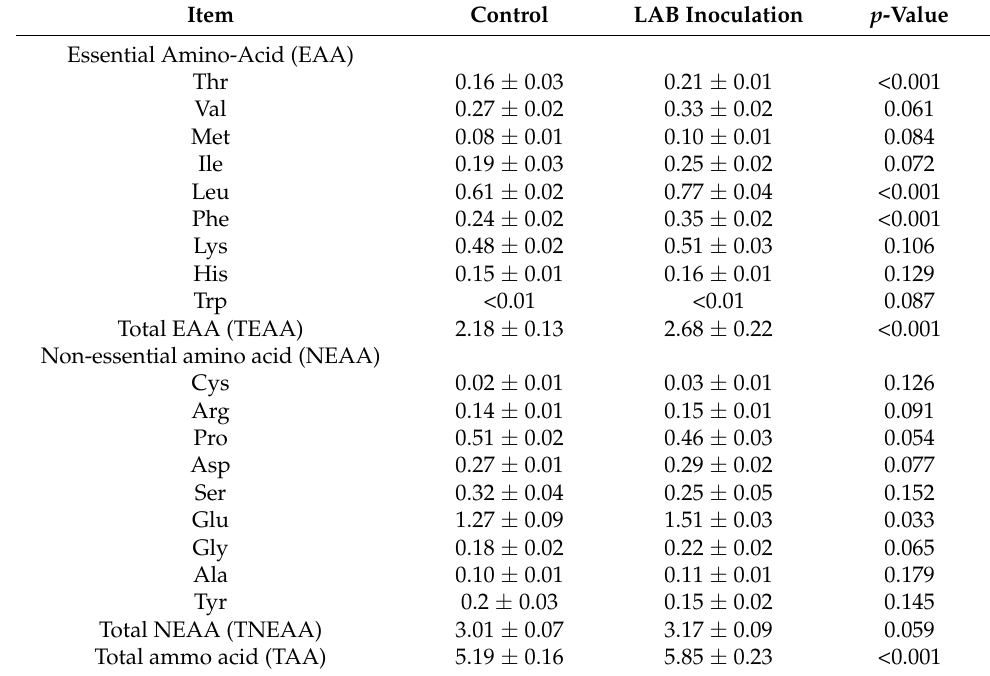
Table 4. Amino acid composition (g/100 g milk) of yak individual milk. Item Control LAB Inoculation p